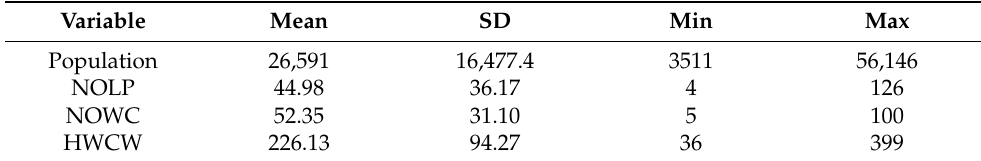
Table 4. Descriptive Values of the Variables.